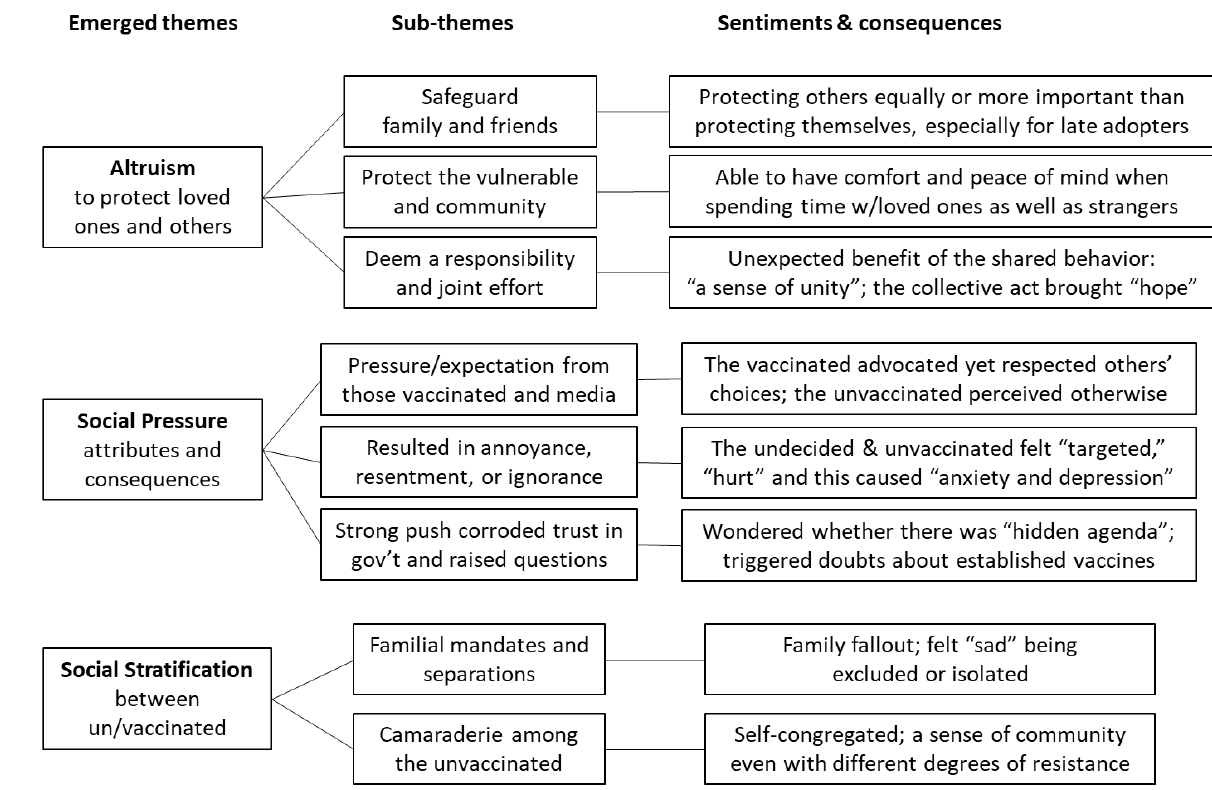
Figure 1. The influence of social norms and pressure on COVID-19 vaccine behavior.